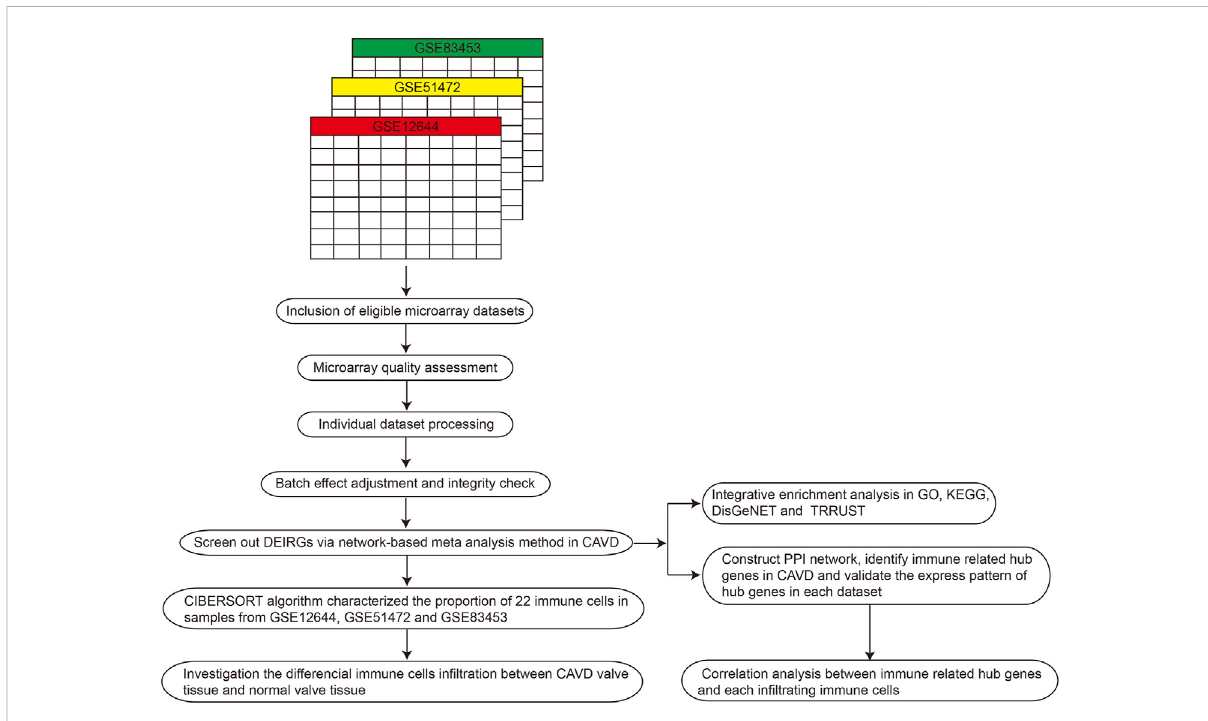
FIGURE 1 Work fl ow of the present systematic review and meta-analysis. PPI, protein – protein interaction; GO, gene ontology; CAVD, calci fi c aortic valve disease; DEIRGs, differentially expressed immune related genes; KEGG, kyoto encyclopedia of genes and